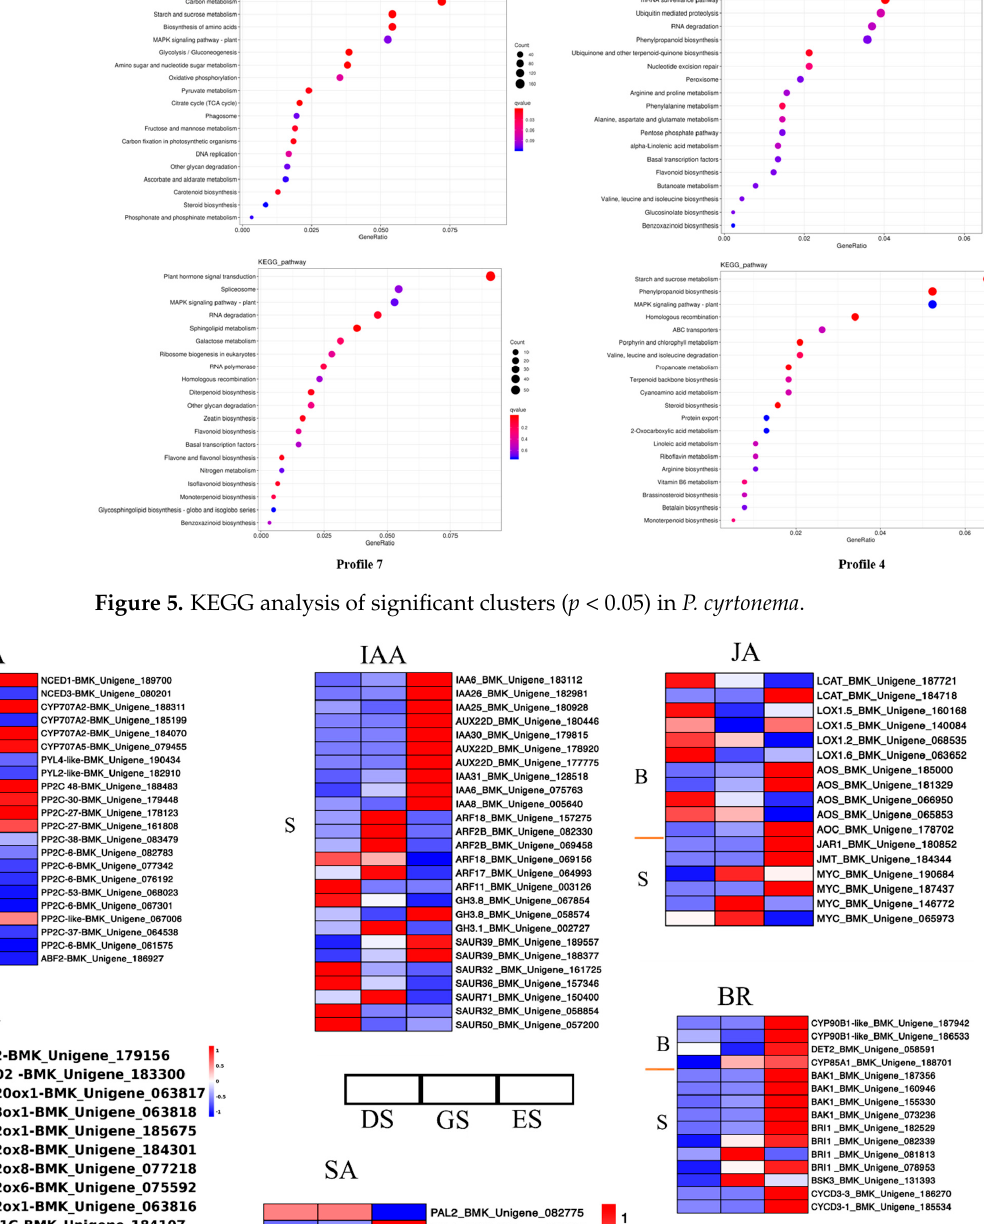
Figure 4. Expression patterns of differentially expressed genes (DEGs) during different stages in P. cyrtonema Hua. ( A ) Changes in gene expression profile during different dormancy phases. ( B ) Venn diagram of DEGs. ( C ) Trend analysis of all DEGs. The cluster trend of white background is not significant, and the trend of color background is significant ( p < 0.05).